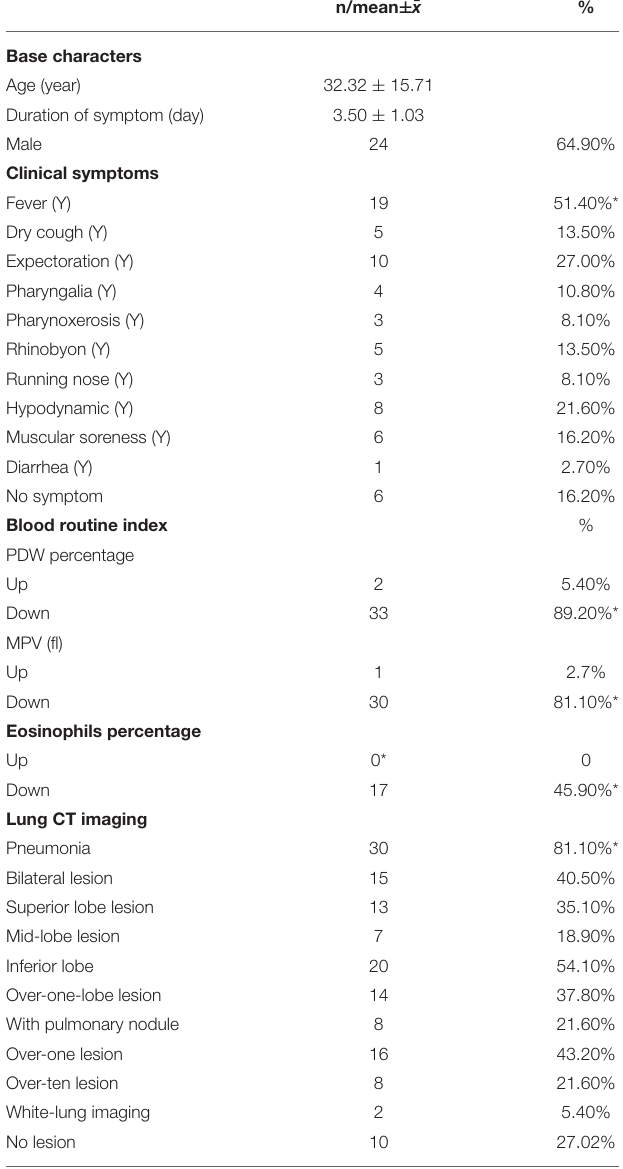
TABLE 1 | The base characteristics and clinical symptoms of positive COVID-19